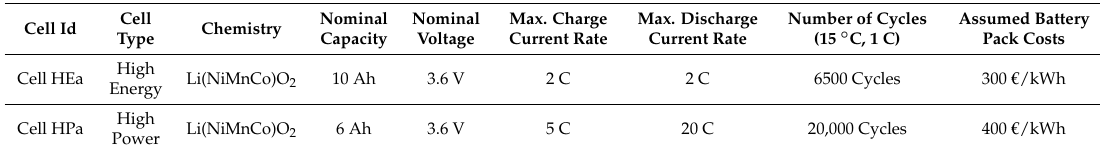
Table 1. Technical data of cells contained in the electric cell model and assumed costs of battery pack containing the particular cell